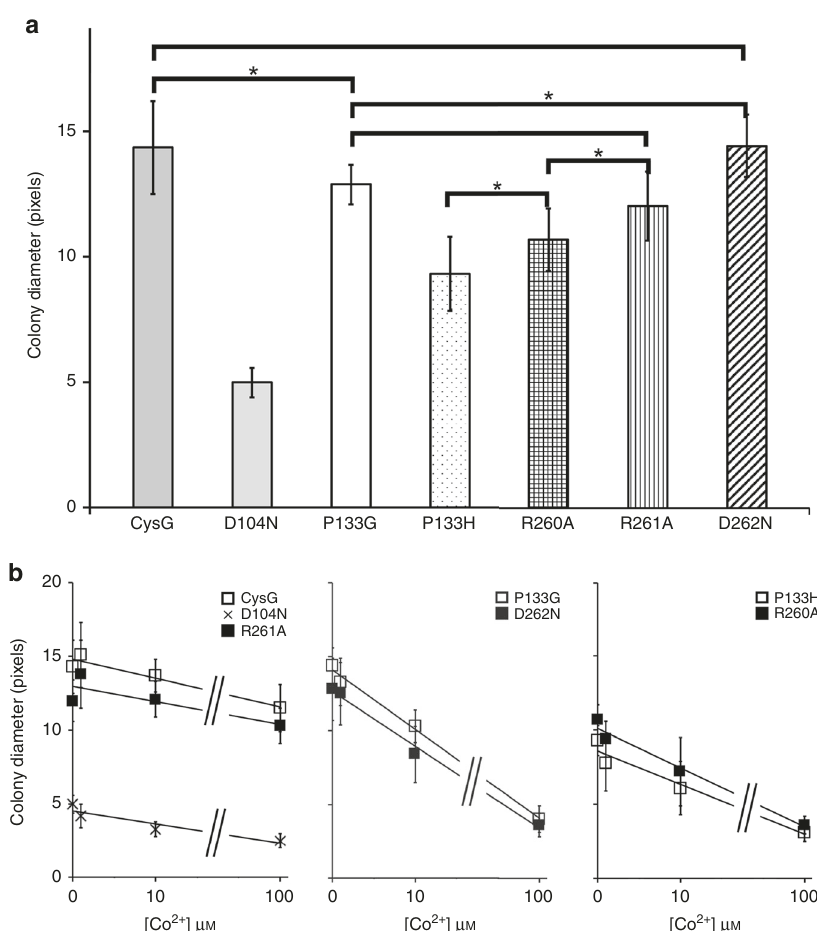
Fig. 4 CysG variants respond differently to cobalt challenge. a ANOVA pairwise comparison in a two-tailed test of CysG-de fi cient E. coli expressing each variant ( n = 18, CysG; = 37, D104N; = 21, P133G; = 25, P133H; = 18, R260A; = 18, R261A, = 15, D262N) was used to show which were statistically impacted by growth on M9 media. All were different than one another with a p value of < 0.001 (see Supplementary Table 1 for details) except those marked here. “ * ” ≤ 0.5 and statistically indistinguishable. There was a signi fi cant effect of the CysG variant with an F value of 168.5 and 6 degrees of freedom. Error bars show standard deviations. b ANCOVA analysis of the impact of increasing cobalt concentration on colony size for CysG-de fi cient E. coli expressing each variant, interpreted as the slope of the line shown in each graph, followed by ANOVA analysis of the slopes to assess whether each variant was affected in a similar or different way. There was a signi fi cant interaction between each CysG variant and cobalt concentration with an F value of 43.1 and 6 degrees of freedom (number of colonies counted for each Co 2 + concentration provided in Supplementary Table 2). Three groups arose: those that were affected like CysG (D104N and R261A), those that were dramatically affected (P133G and D262N), and those that were more modestly affected (P133H and R260A). Error bars show standard deviations. Source Data are provided as Source Data File